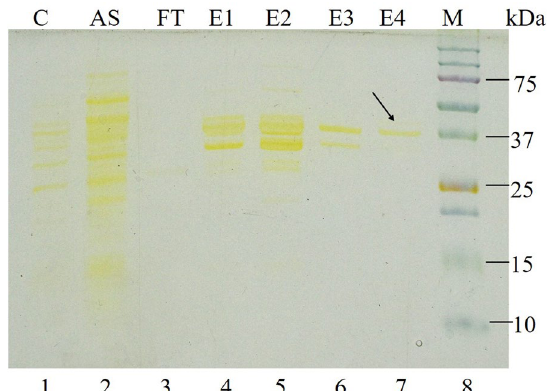
Fig. 3 SDS-PAGE analysis of purified PCH199 L-ASNase. Proteins were separated on 10% SDS-PAGE and stained with silver stain. Lane